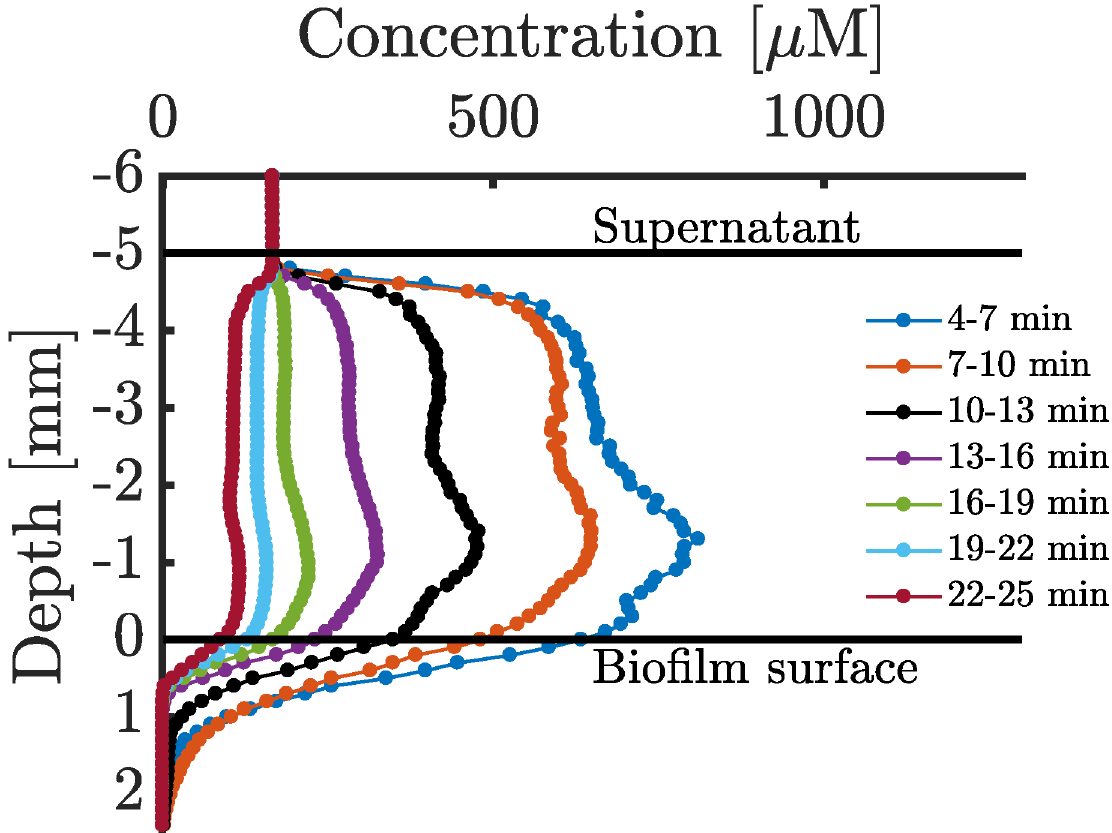
Fig 1. Oxygen profiles sampled after 90 minutes of HBOT. Oxygen profiles are recorded after 90 minutes of HBOT applied to a 5 mm thick agarose biofilm, hence an unloading process of an already oxygen penetrated biofilm is observed. Oxygen profiling was initiated 4 minutes after the 90 minutes HBOT and every profile takes approximately 3 minutes to record. Horizontal black bars represent supernatant and biofilm surfaces, respectively. The concentration of oxygen in the supernatant immediately after treatment is approximately 1000 μ M as the chamber has to be decompressed to 1 atm. The biofilm is present for depth 0 mm to 5 mm while the supernatant is present in the region from −5 mm to 0 mm. The supernatant is displayed primarily to verify that the mixing is strong in this region. Figure modified from [3].